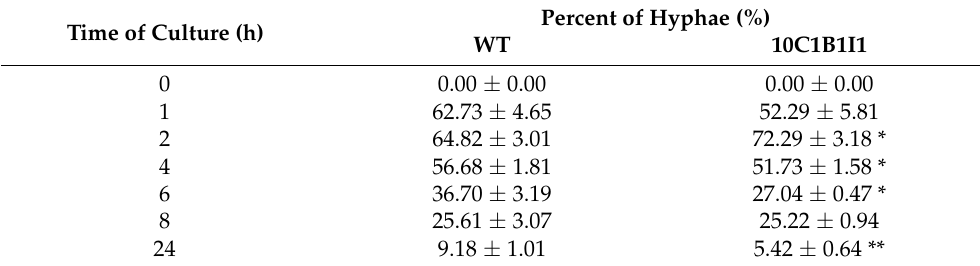
Table 1. Percent of hyphae cells (%) in C. albicans WT (SC5314) and 10C1B1I1 ( ERG11 K143R / K143R ) strains culture with the addition of FBS (20%) in different time points (0, 1, 2, 4, 6, 8 and 24h). For this purpose, micrographs were analyzed for mean percent of hyphae ( n = 300; ± SD); Results obtained for C. albicans 10C1B1I1 strain in different time points were compared to WT strain (* p < 0.05; ** p < 0.01). Percent of Hyphae (%) Time of Culture (h) WT 10C1B1I1 0 0.00 ±